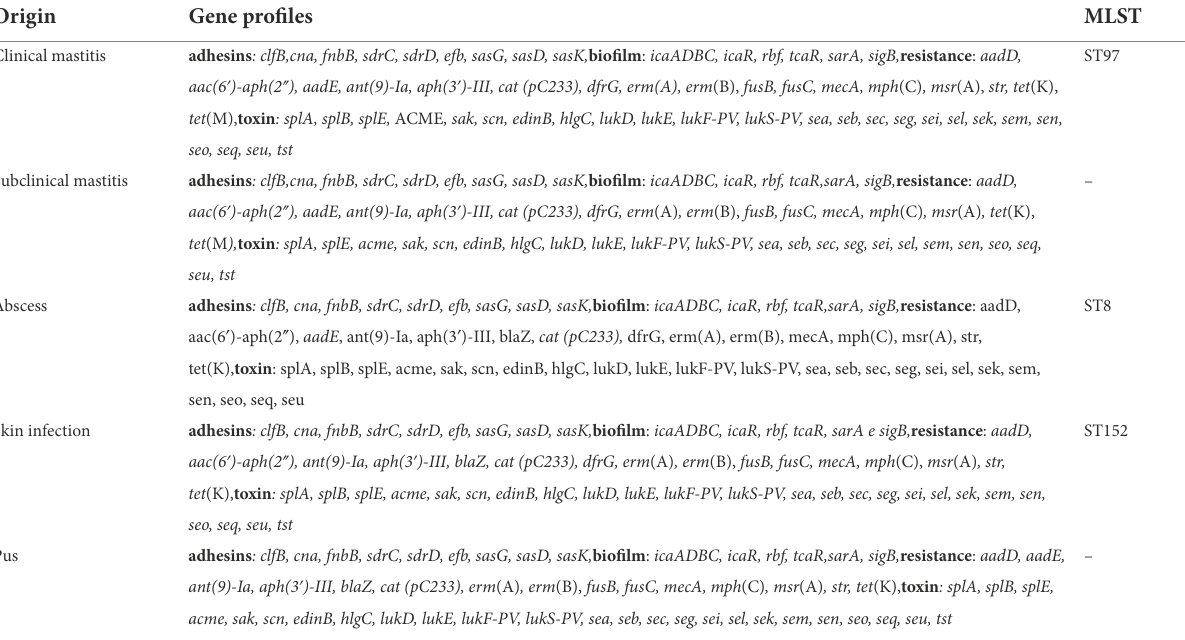
TABLE 1 Significant gene profile by Fisher’s exact test and by multinomial logistic regression according to the origin of the isolate and the main sequence type. Origin Gene profiles MLST Clinical